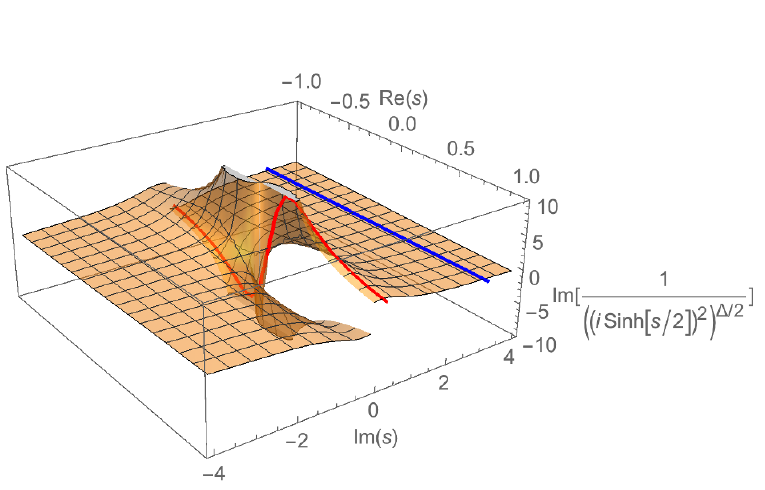
Figure 2 . Branch cut structure of the correlator (5.5), along with the original (red) and deformed (blue) contour in